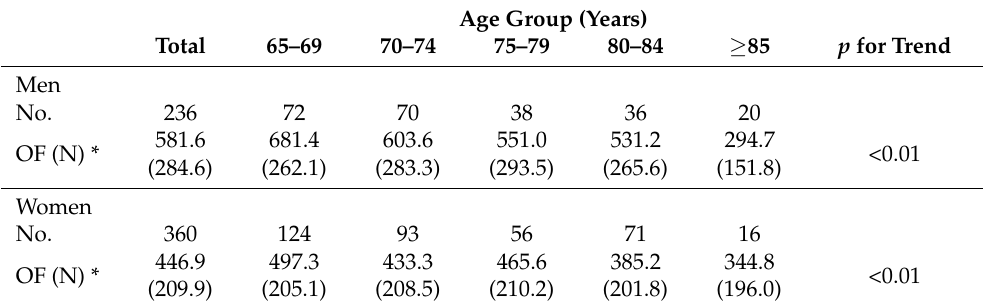
Table 2. Means and standard deviations of occlusal force according to age group and